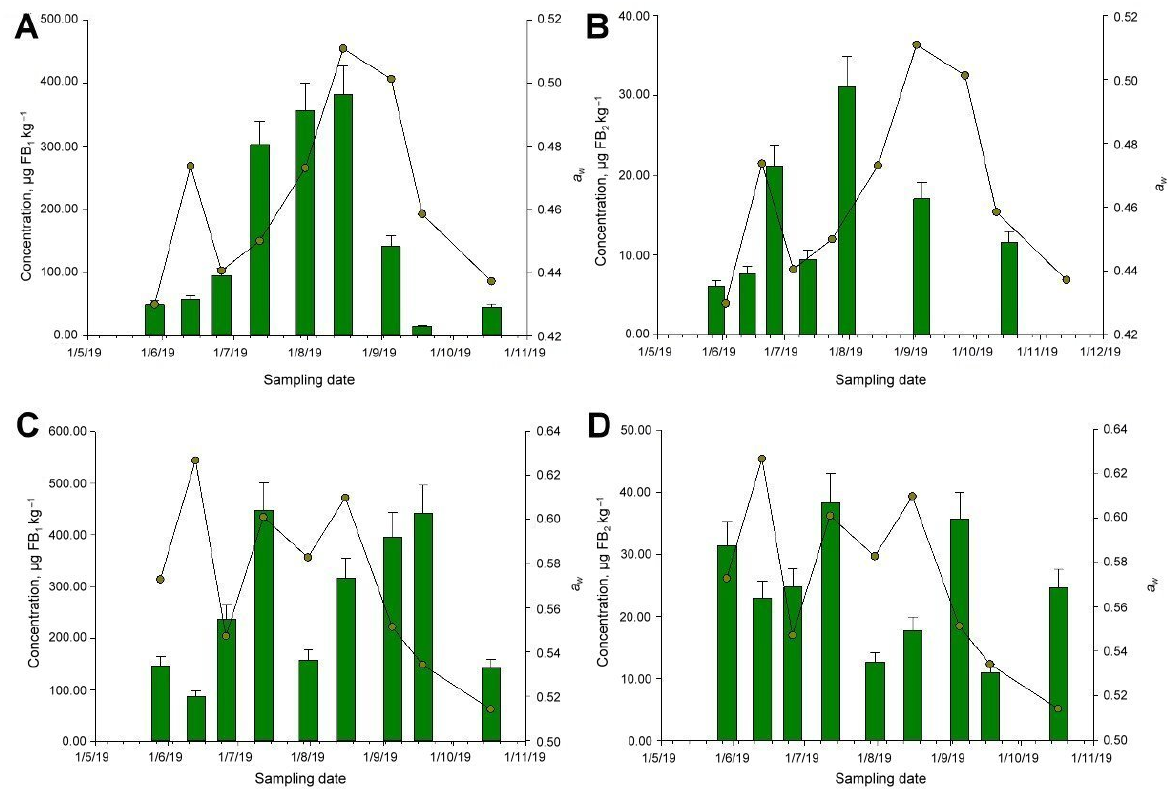
Figure 3. Behavior of fumonisin fractions B 1 ( A , C ) and B 2 ( B , D ) and of water activity over time for a stored animal feed Figure 1. ( A , B ) and supplier 2 ( C , D ). Green bars represent fumonisin levels, whereas line and scatter plots represent a w levels. Fumonisin B 1 and B 2 were selected, as they are the most common toxins found in the samples tested.